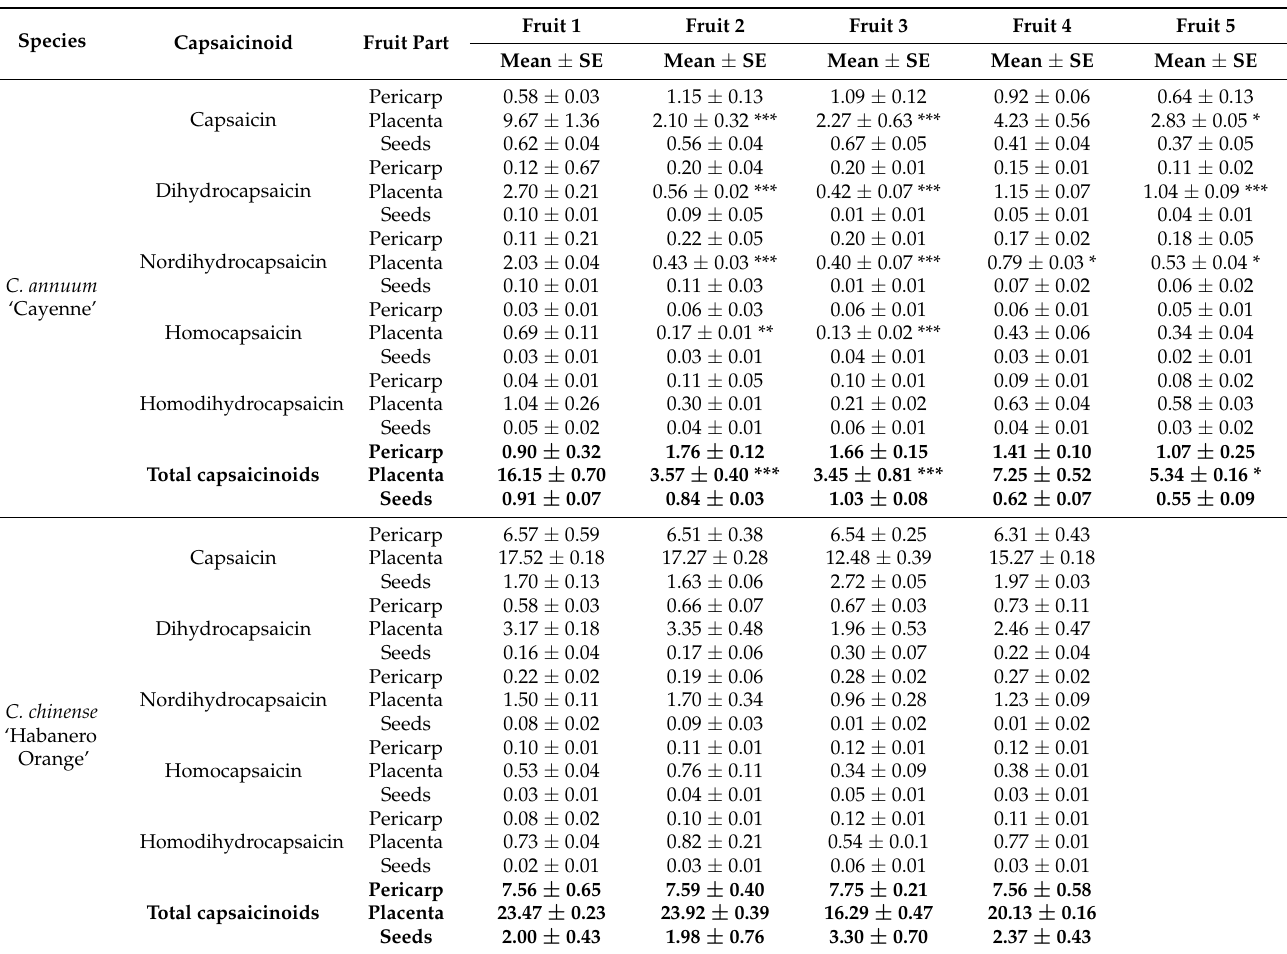
* symbol indicates statistical significant differences of each fruit and fruit part when comparing to the first fruit on the plant. Significance codes: *** ≤ 0.001; ** ≤ 0.01; * ≤ 0.05; ‘empty slot’ ≥ 0.05. Table 5. Individual and total capsaicinoids contents (g/kg DW, mean ± SE) in different species and three fruit